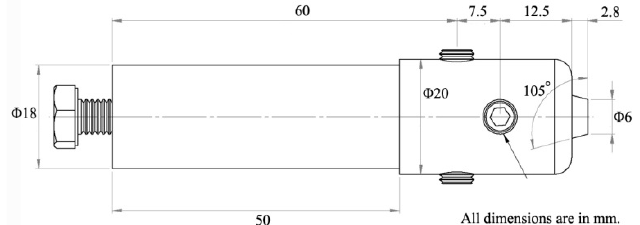
Figure 2. Schematic design and geometry of the tool used for FSW and FSVW processes.